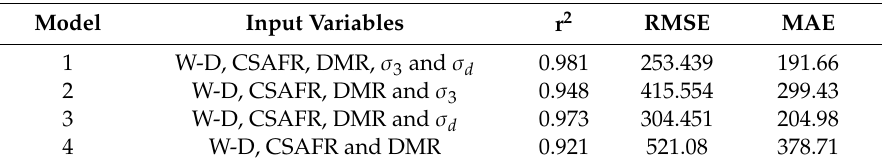
Figure 3. Scatter plot of the three investigated models: ( a ) training, ( b ) testing. Table 3. Input variable effect on the PSO-ELM model.